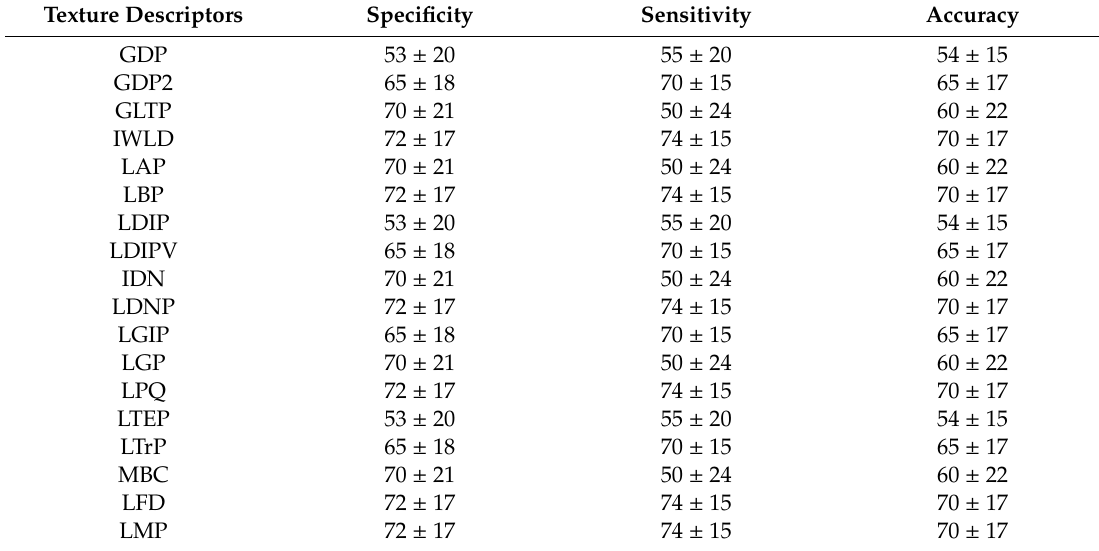
Table 6. Comparison of our purposed algorithm with existing work.